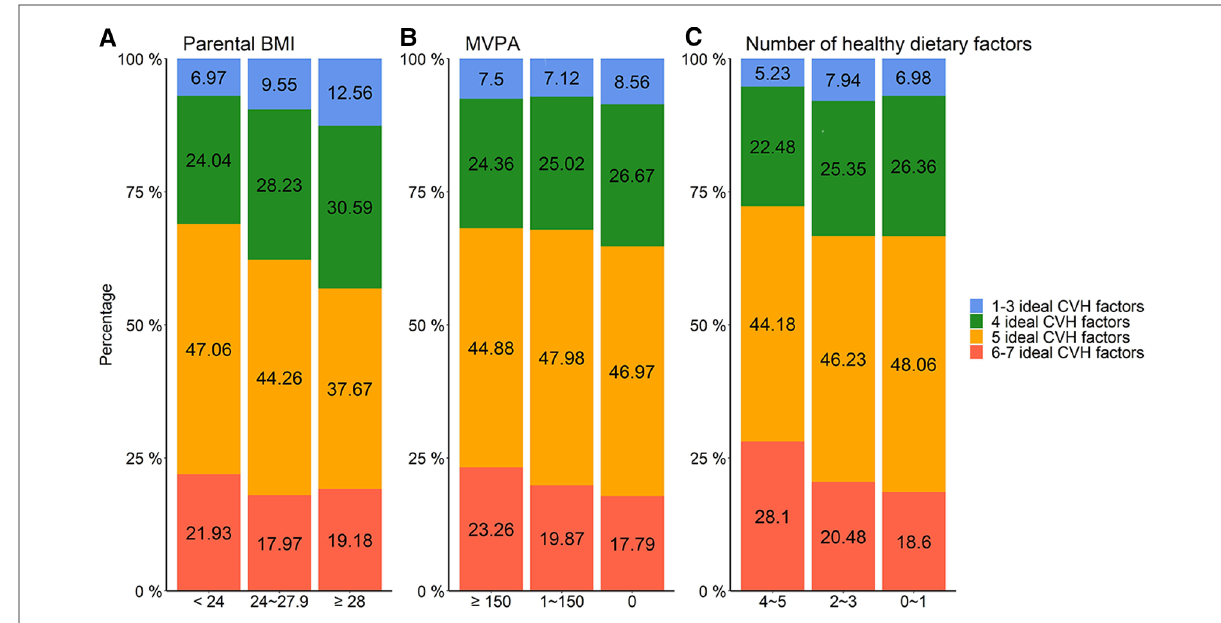
FIGURE 2 Distribution of participants in different CVH status according to parental behaviors: ( A ) parental BMI, ( B ) MVPA, and ( C ) number of healthy dietary factors. CVH, cardiovascular health; BMI, body mass index; MVPA, moderate to vigorous physical activity.